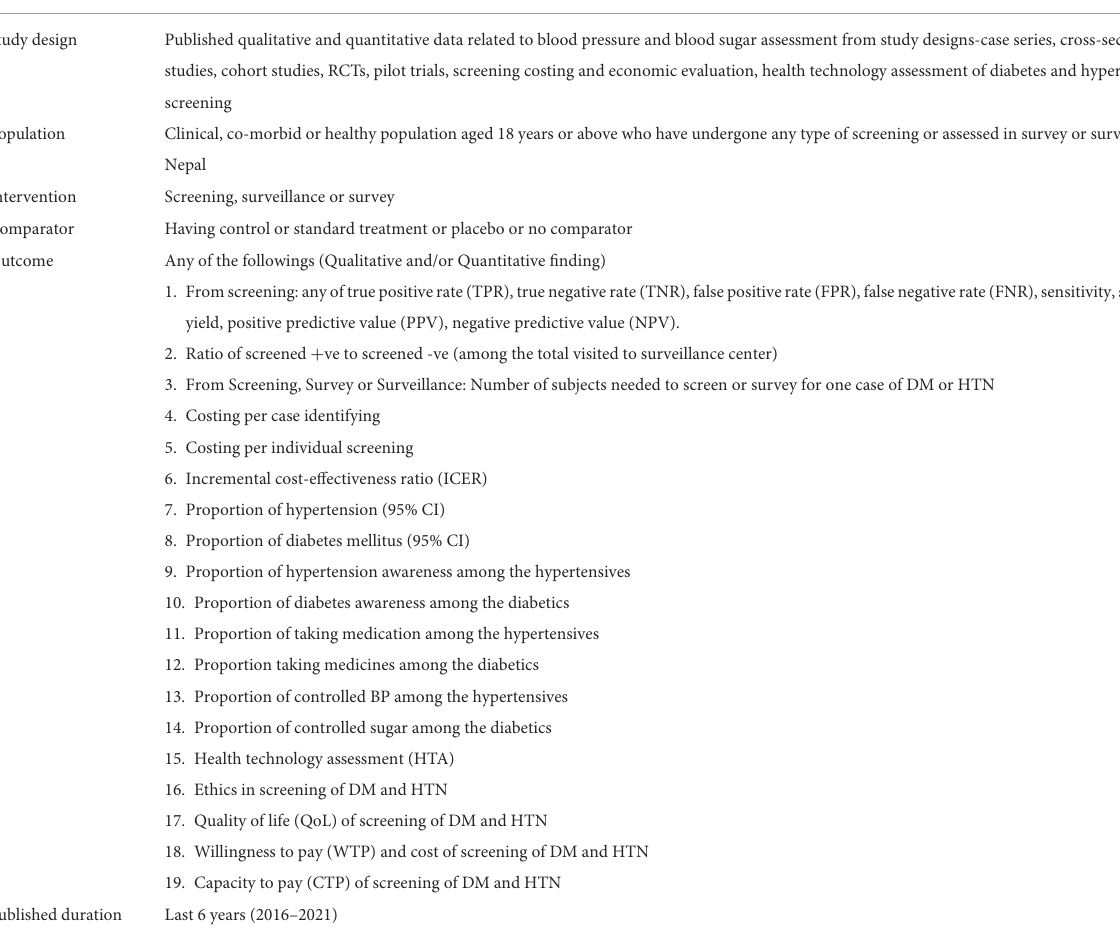
TABLE 1 PICO indicators and criteria for scoping review. PICO/Indicator